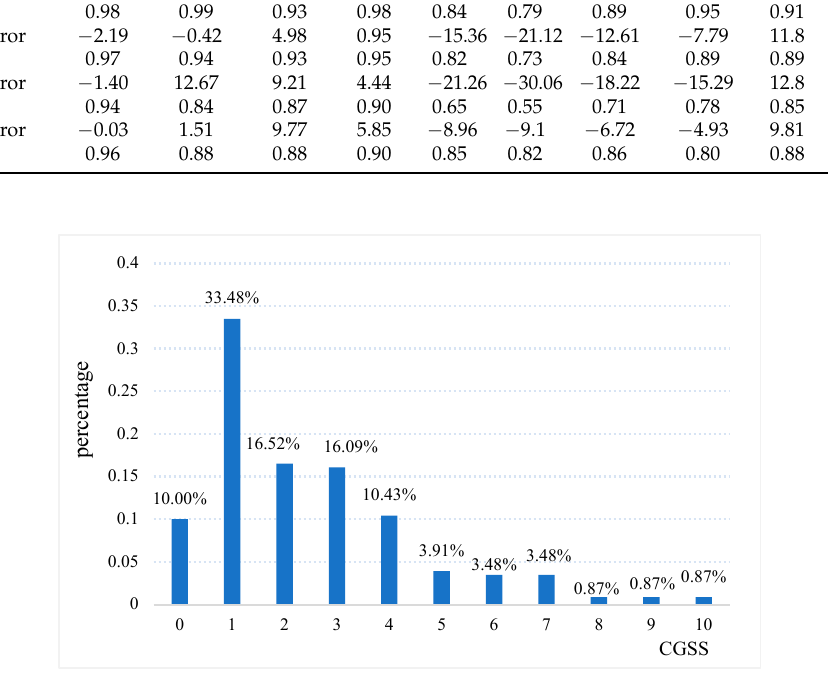
Figure 9. Percentage of trees with di ff erent CGSS.